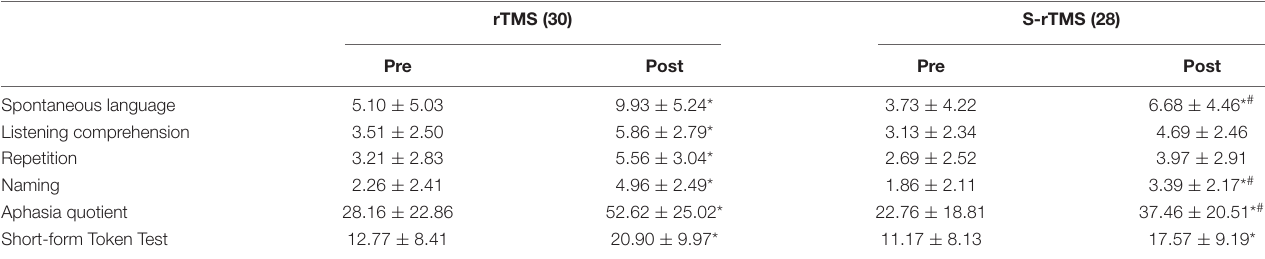
TABLE 2 | Evaluation results and statistical analysis of the clinical scale for the two groups of